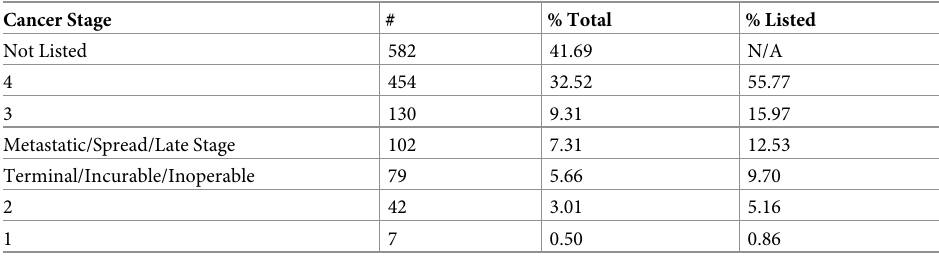
Table 2. Recipient cancer